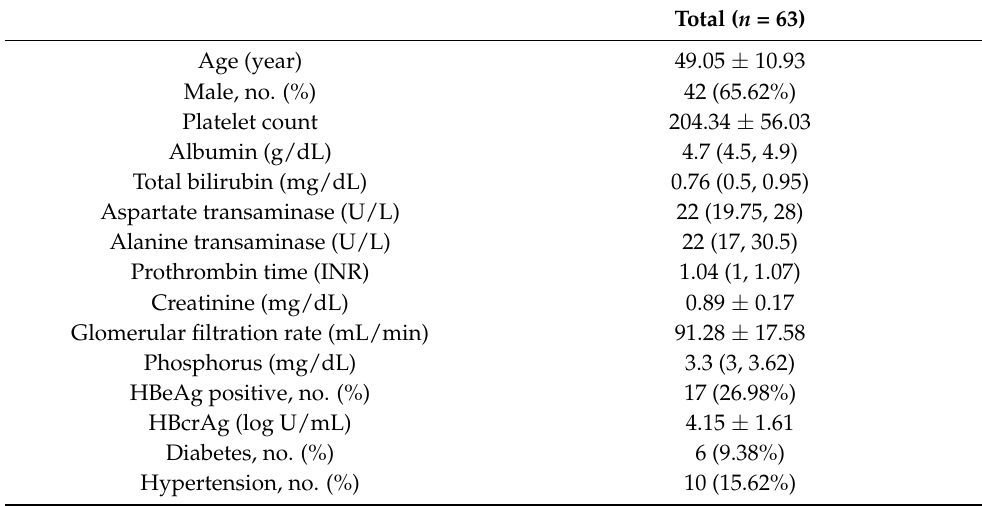
Table 1. Baseline characteristics of the study population.